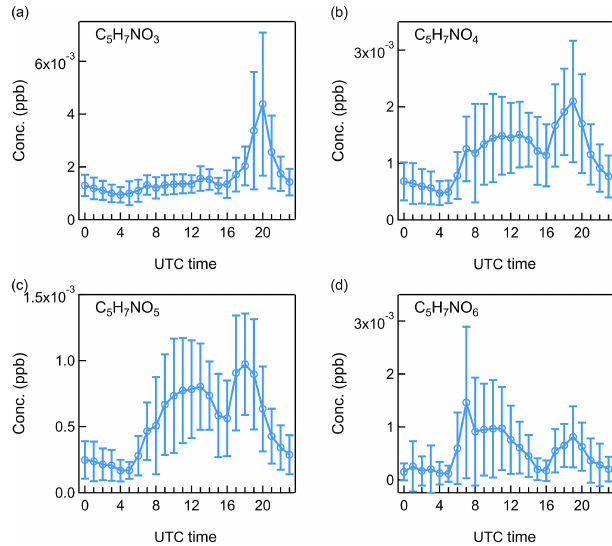
Figure 10. Diurnal patterns of isoprene-derived organic nitrates: (a) C 5 H 7 NO 3 , (b) C 5 H 7 NO 4 , (c) C 5 H 7 NO 5 , and (d) C 5 H 7 NO 6